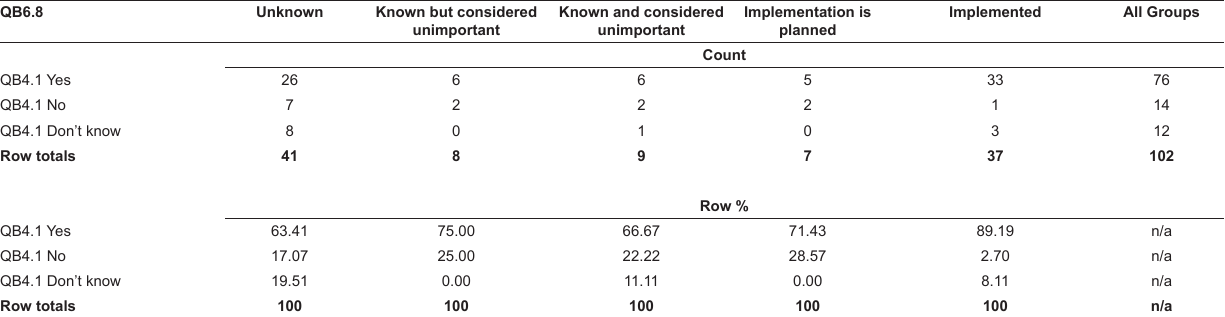
TABLE 10 Summary frequency table QB6.8(5) × QB4.1(3): top management’s ethical leadership and CEO commitment